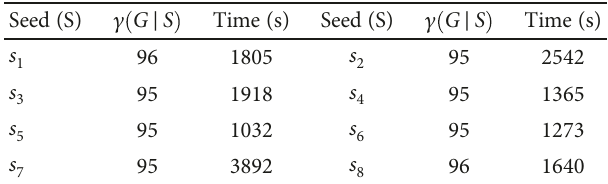
Table 1: The results for extending seeds from S .